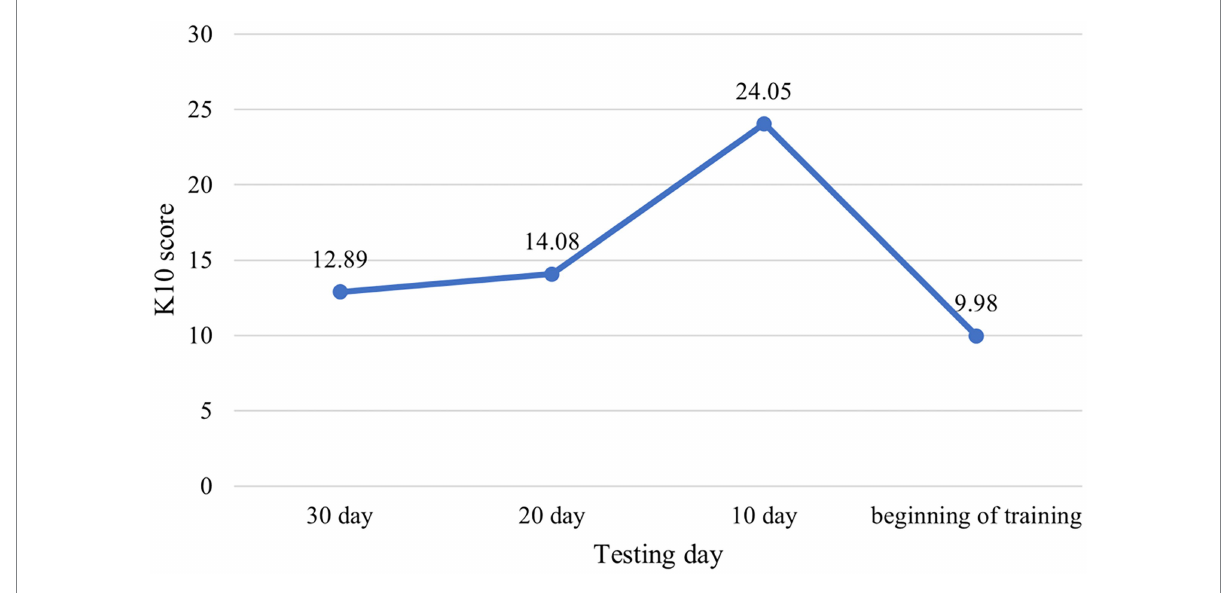
FIGURE 1 K10 pre-examination